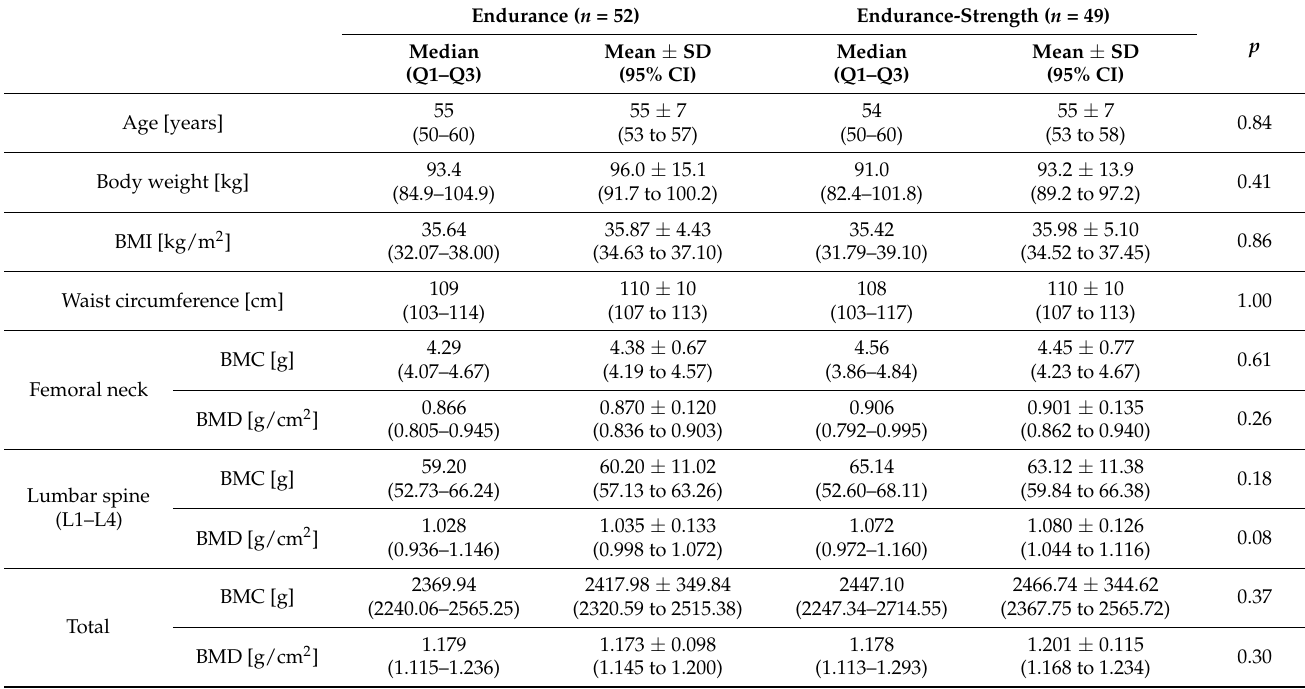
Figure 3. CONSORT 2010 flow diagram [32]. The figure was previously published in the Journal of Clinical Medicine , which publishes articles under an open access Creative Common CC BY license. Table 1. Baseline characteristic of the study population ( n =